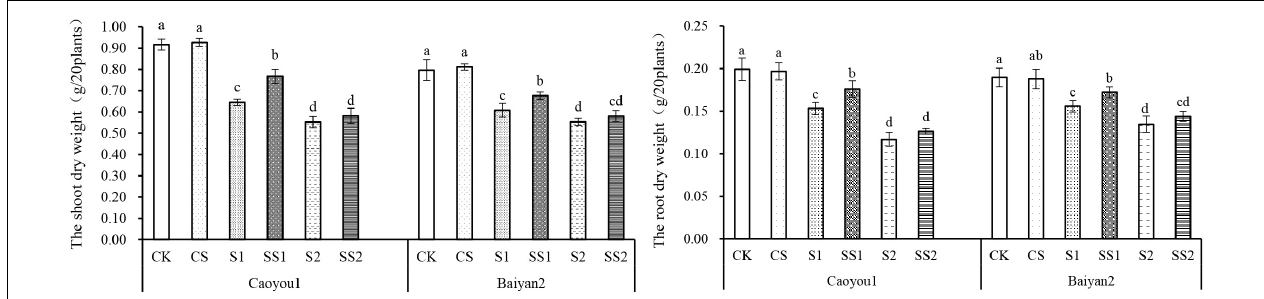
FIGURE 9 | Effects of Spd application on dry weight under salt stress in the oat seedlings. CK, Nutrient solution + distilled water; CS, Nutrient solution + 0.75 mM Spd; S1, 70 mM salt + distilled water; SS1, 70 mM salt + 0.75 mmol/L Spd; S2, 100 mM salt + distilled water; SS2, 100 mM salt + 0.75 mmol/L Spd; Different lowercase letters indicate significant differences between treatments at 0.05